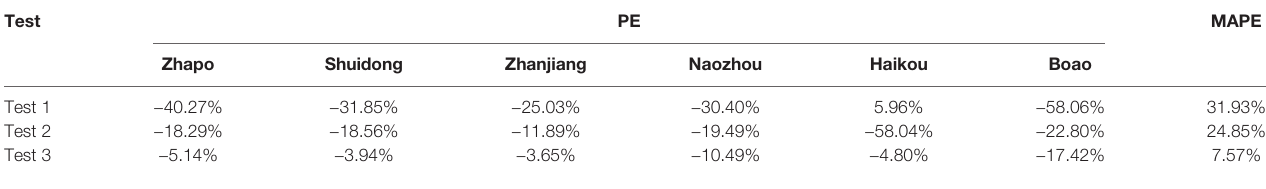
TABLE 1 | PEs of peak surge between model simulation and observation under Tests 1 –